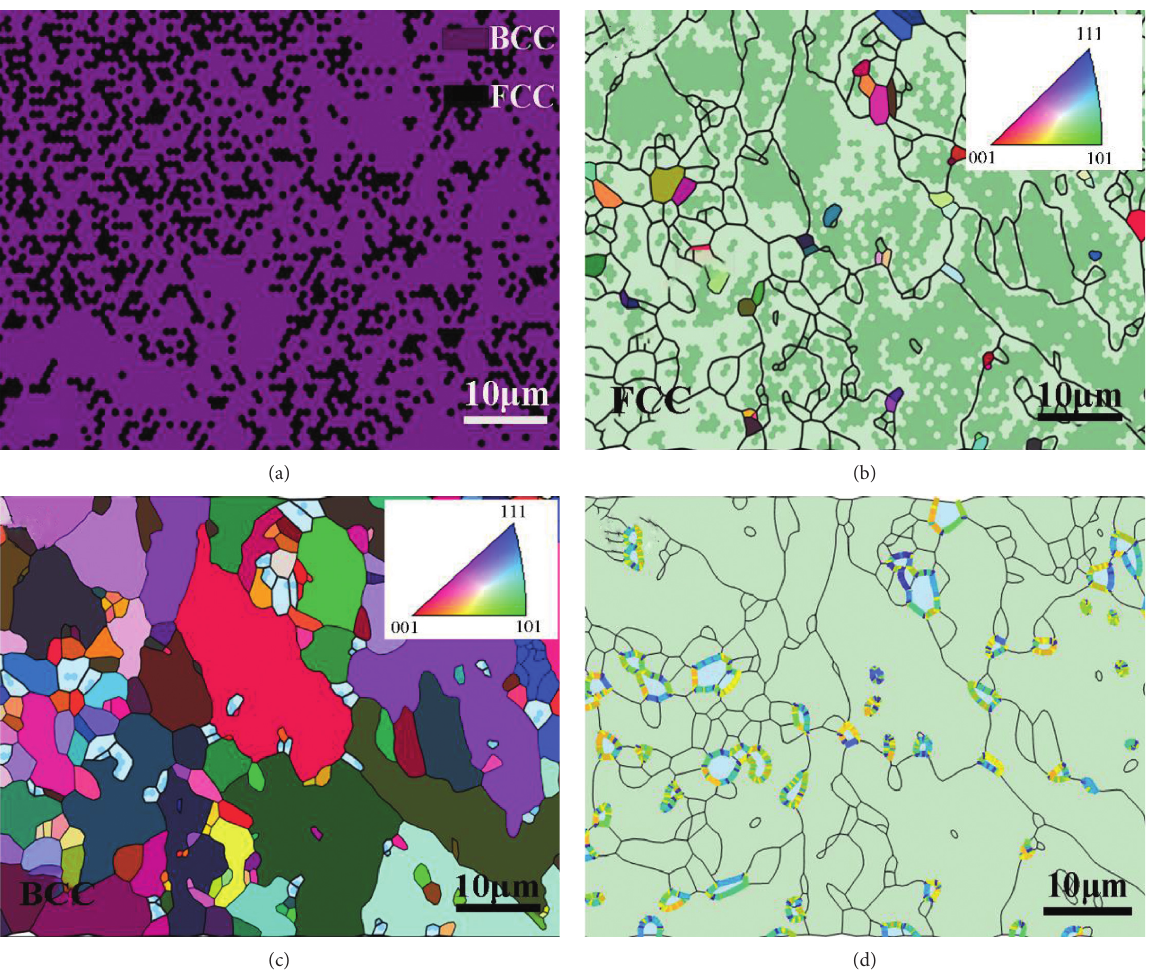
Figure 7: DCTat − 110 ° C and tempering at 350 ° C. (a) Image of phase, (b) misorientation image of FCC, (c) misorientation image of BCC, and (d) image of grain